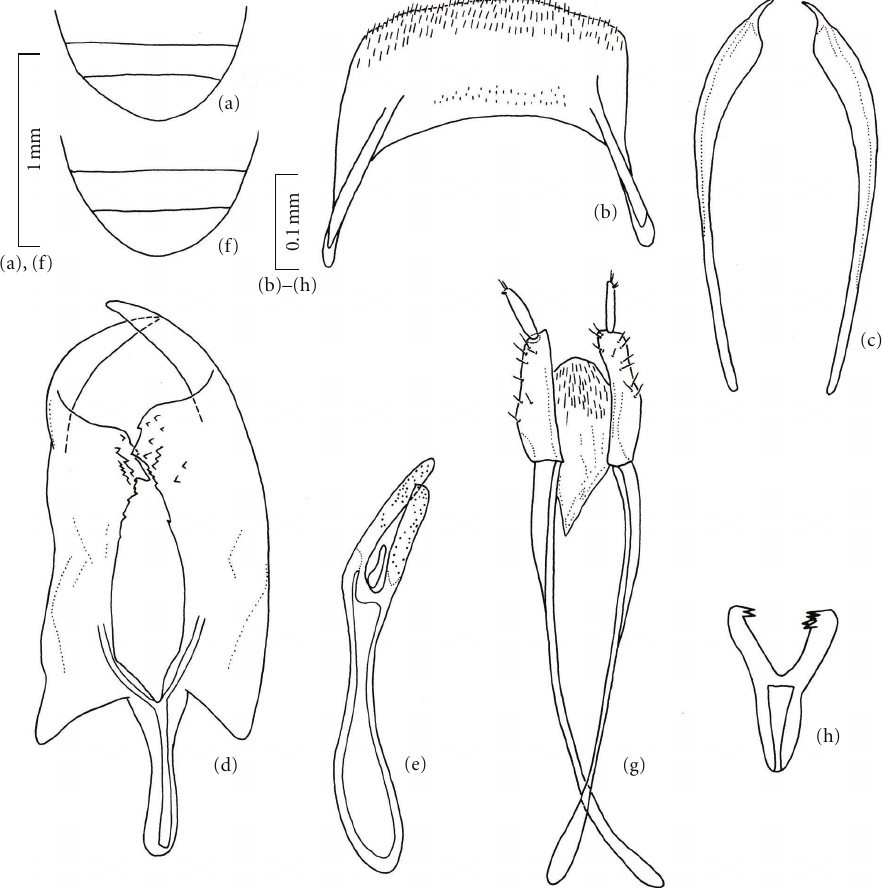
Figure 3: Hydrocyphon takizawai sp.n., holotype, male (a–e) and paratype, female (f–h). (a, f) Sternites V–VII; (b) tergite VIII; (c) sternite IX; (d) tegmen; (e) penis; (g) ovipositor; (h) prehensor.